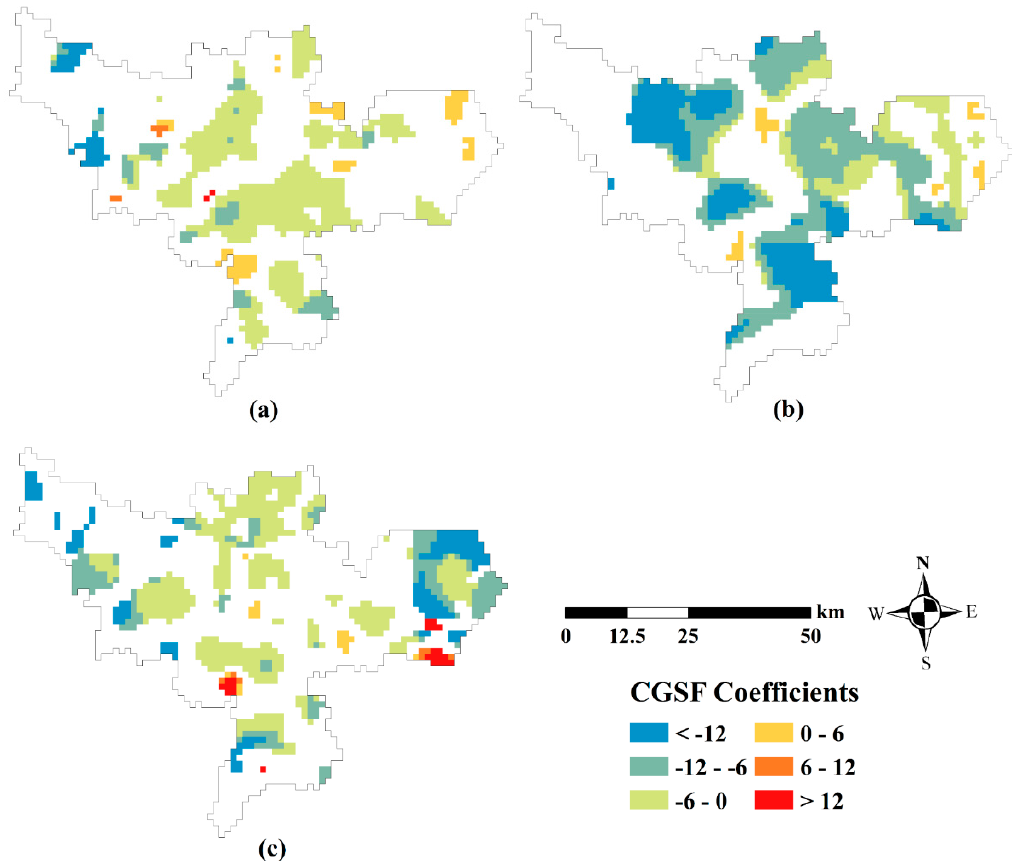
Figure 10. Spatial variations in significant local parameter estimates for the relationship between CGSF and CSUHII: ( a ) 2000 – 2005; ( b ) 2005 – 2010; ( c ) 2010 –